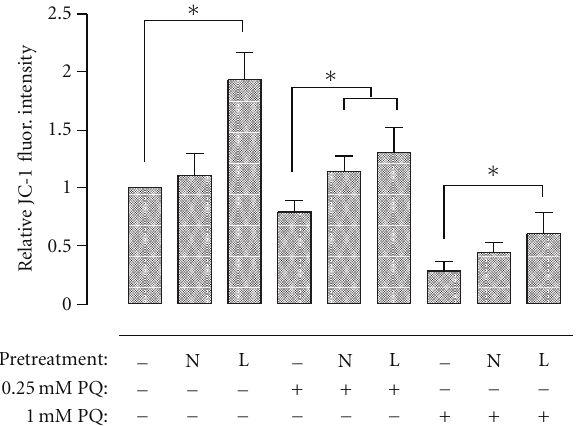
− − −− − − − − Figure 5: E ff ect of NAC or L-NAC pretreatment on IL-8 levels after PQ exposure. Cells pretreated for 4h with control media or 5.0 mM NAC- (N) or L-NAC-containing media (L) were challenged with 0, 0.25, or 1.0 mM PQ for 4h. Cell culture supernatants were collected immediately following challenge and concomitantly analyzed for IL-8 using the Bio-Plex suspension array system. Bars represent mean ± S.E.M. of 3 independent experiments. ∗ denotes significant di ff erence relative to cells with no pretreatment ( P < .